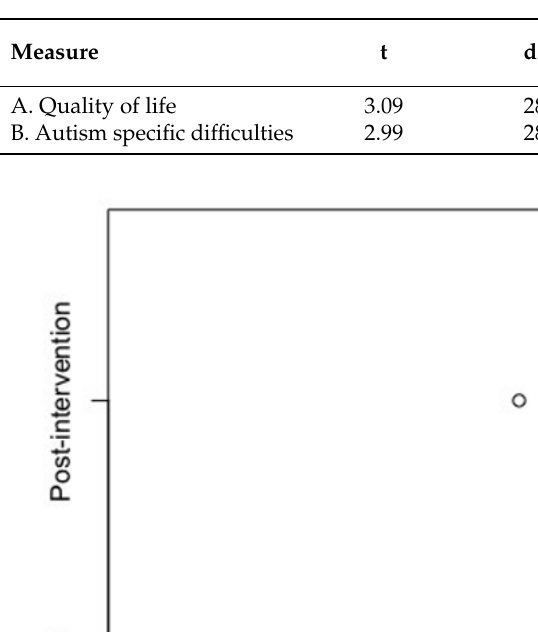
Table 3. Paired t-tests on QoLA pre- and post-intervention (N = 29). Table 3. Paired t -tests on QoLA pre- and post-intervention (n = 29).